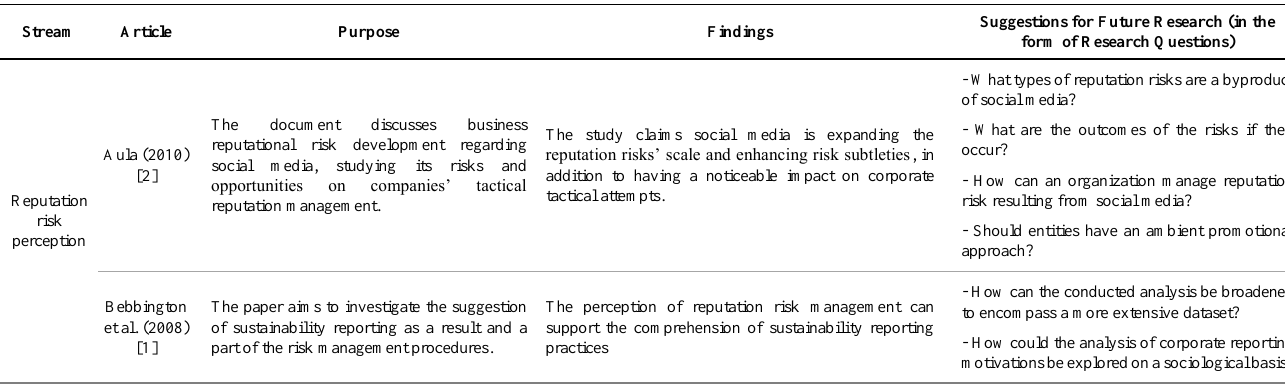
Table 7. Cluster analysis of published reputation risk